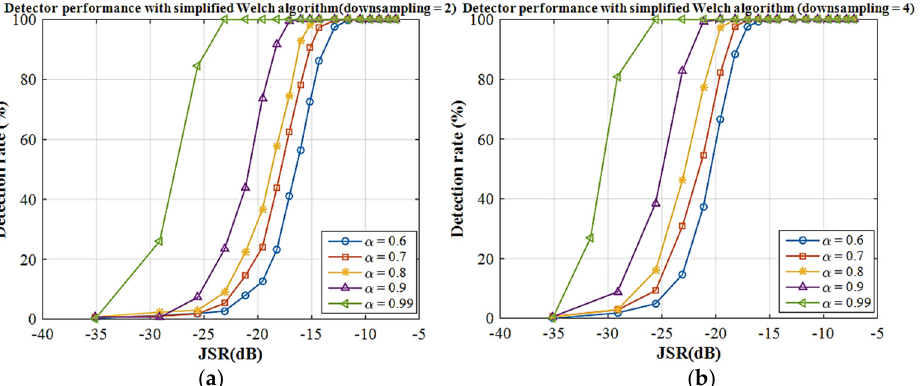
Figure 13. Correct detection percentage based on the input JSR (detector with the simplified Welch method); ( a ) downsampling = 2; ( b ) downsampling = 4.